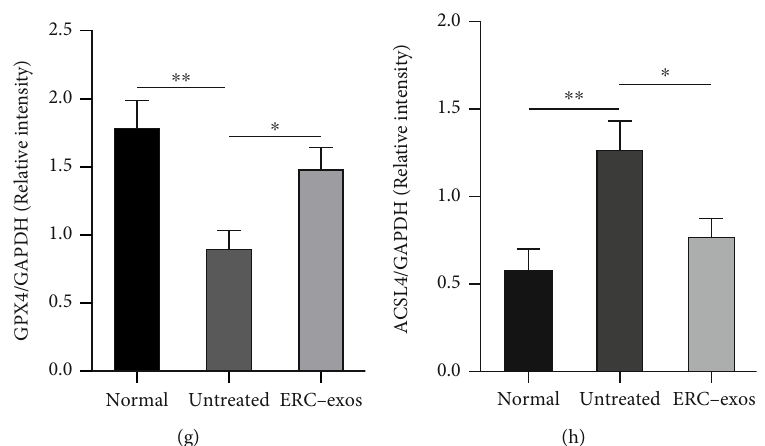
Figure 5: ERC-exos downregulated ferroptosis in mouse colitis model. The levels of (a) iron, (b) GSH, and (c) MDA of colon samples from di ff erent groups were measured. (d, e) Representative images of immunohistochemical analysis measuring GPX4 levels in colons from mice. (f – h) Western blot analysis measuring GPX4 and ACSL4 expression levels in mouse colon samples from di ff erent groups. GAPDH was used as the loading control. The p value was counted by one-way ANOVA. ∗ p < 0 : 05 , ∗∗ p < 0 : 01 , ∗∗∗ p < 0 : 001 , and ∗∗∗∗ p < 0 : 0001